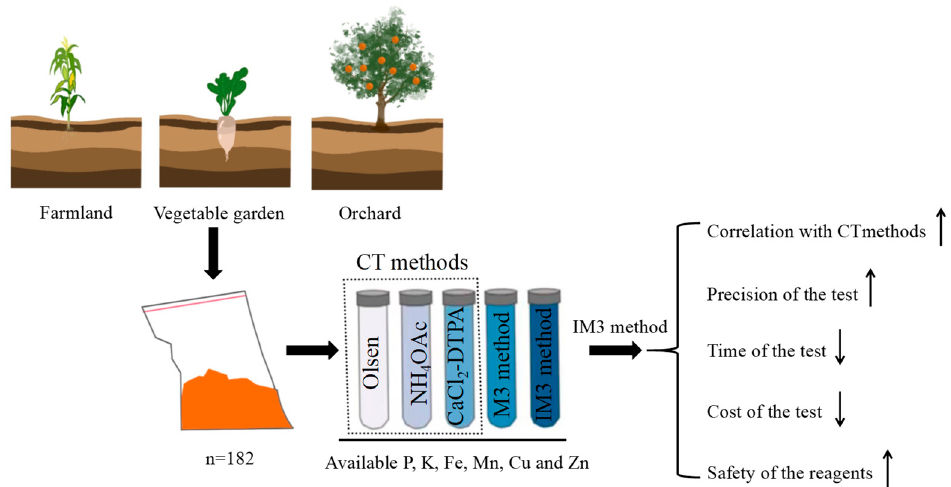
Figure 5. An illustration graph of the results of the three test methods.